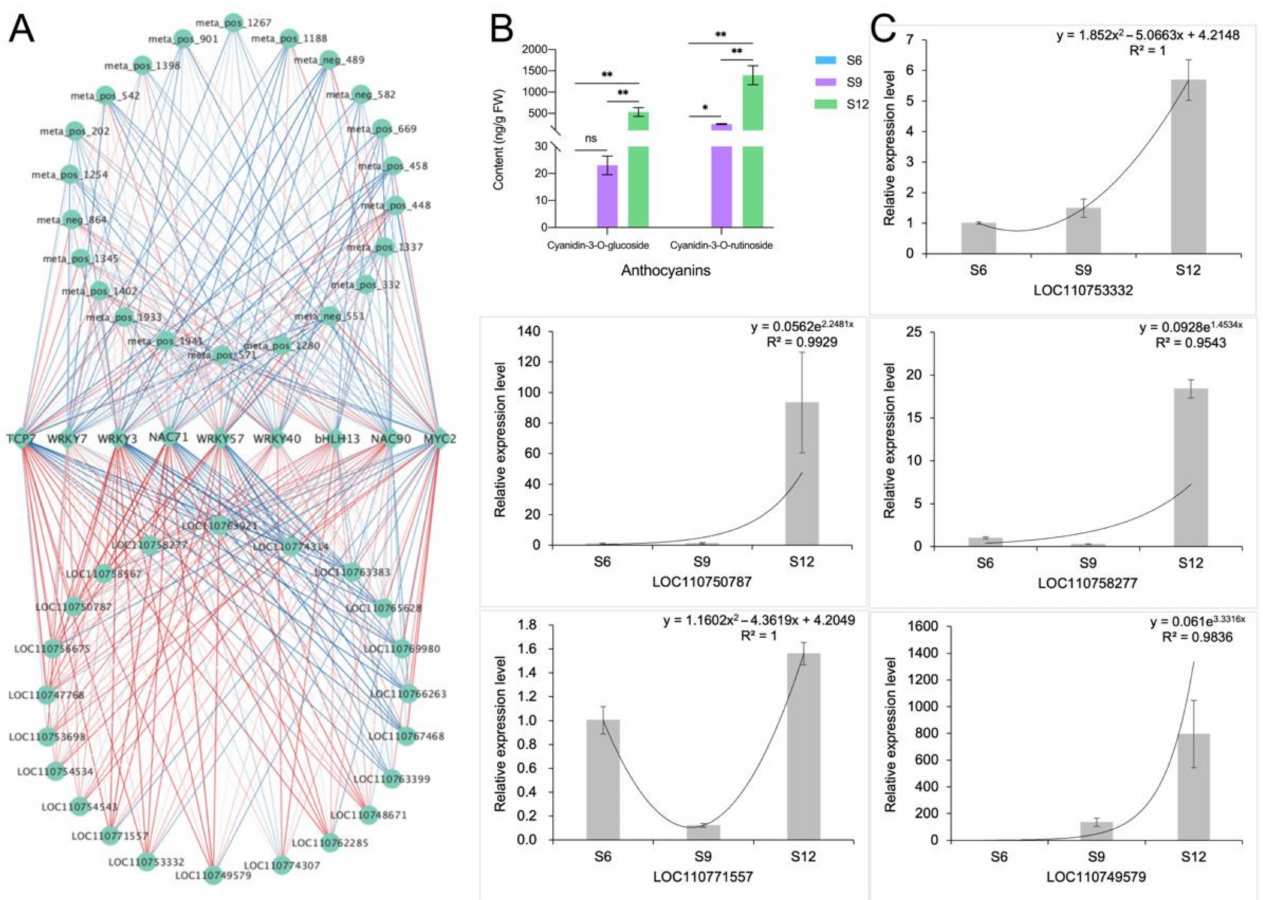
Figure 10. Identification and validation of anthocyanin synthesis correlation network. ( A ) Correlation network identification of 9 transcription factors and anthocyanin synthesis-related DEMs and DEGs. Correlations are represented by blue and red lines from low to high. ( B ) Composition and content of anthocyanins in different developmental stages of sweet cherries. ns means not significant, * indicates significant correlation at the 0.05 level, ** indicates extremely significant correlation at the 0.01 level; ( C ) qRT-PCR analysis of 5 anthocyanin synthesis-related